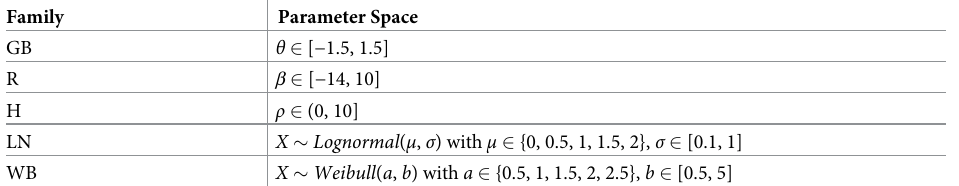
Table 1. Alternative distributions considered in the simulation